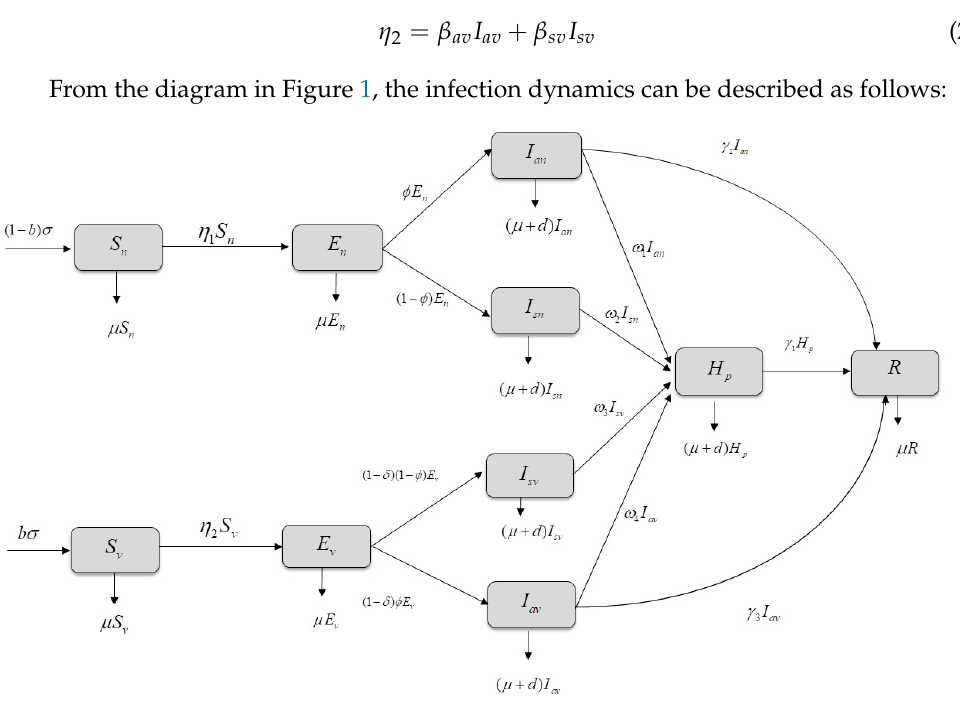
Figure 1. Diagram showing the relationship of the COVID-19 mathematical model and